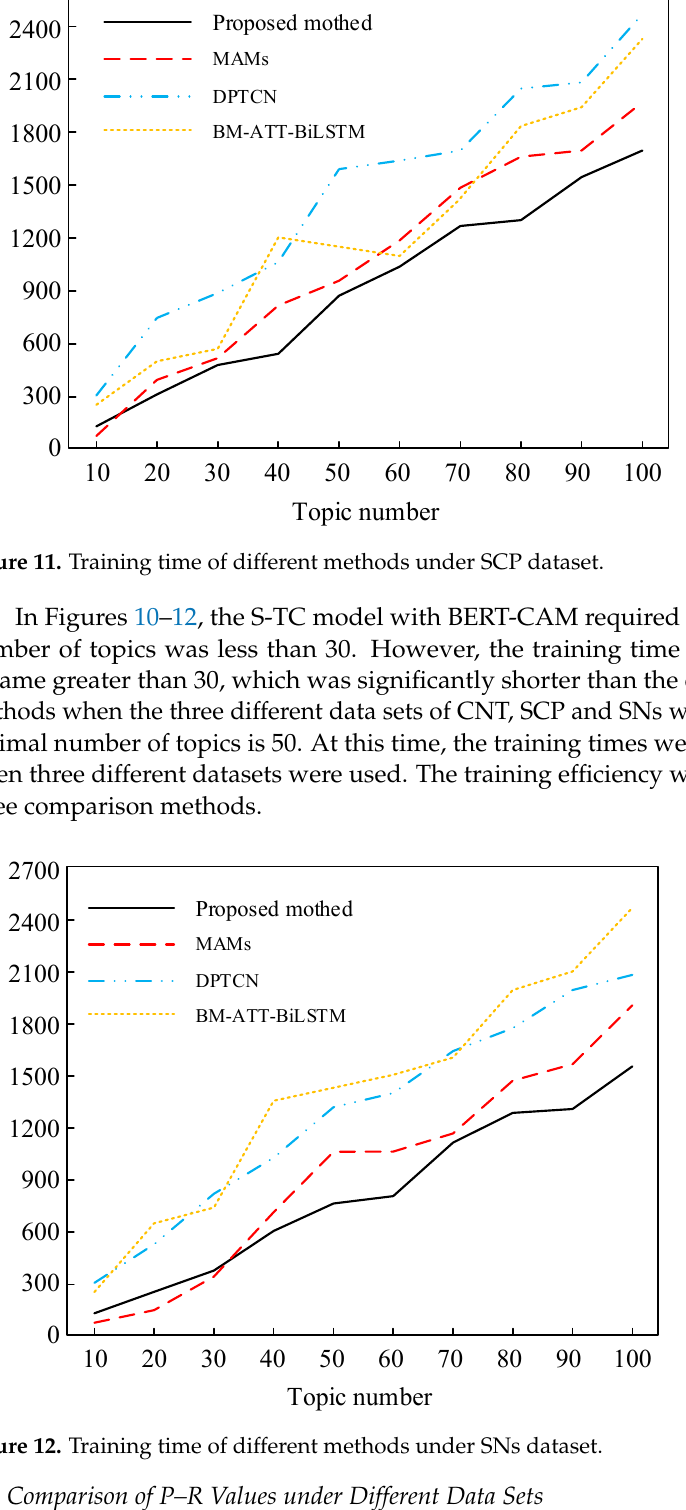
Figure 10. Training time of different methods under CNT dataset.